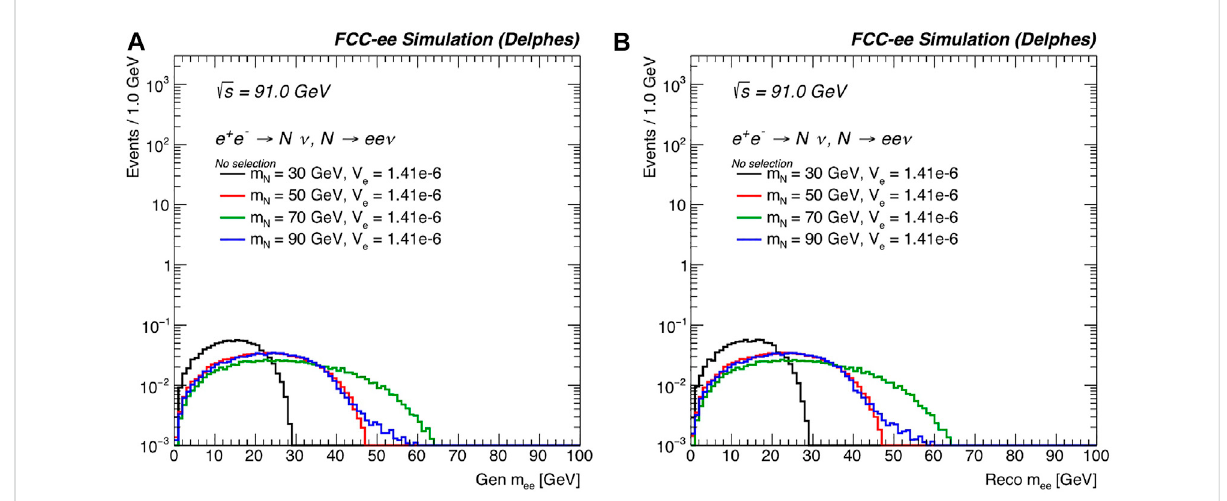
FIGURE 13 Forthesameprocesses andbenchmarkmassand| V eN |choicesasinFigure12,thedifferentialdistributionswithrespecttotheinvariantmassof the( e + e − )system m ee at (A) thegenerator level and (B) after reconstruction.Noselectioncriteriahavebeenapplied.Thedistributionsarenormalized to unit